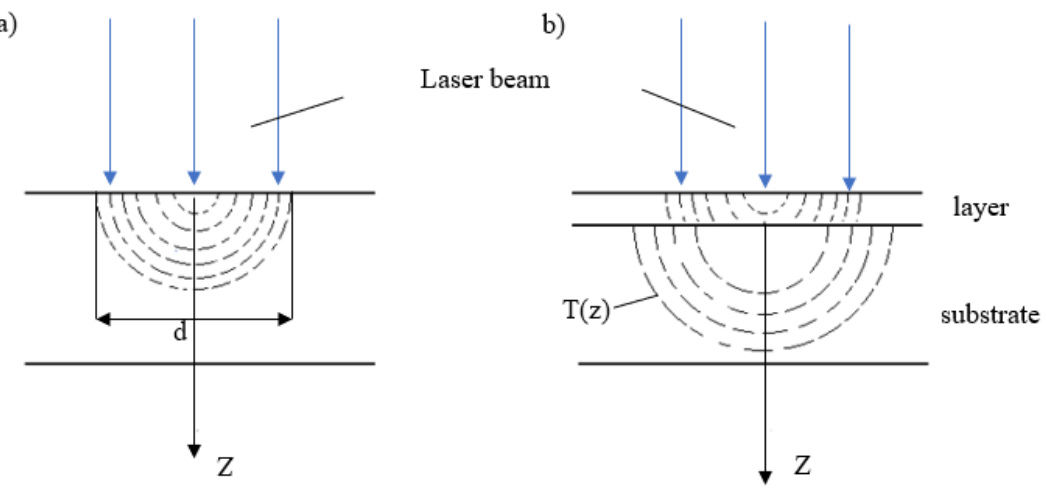
Figure 7. Thermal conductivity at laser heating in ( a ) the bulk sample and ( b ) the layer sample.